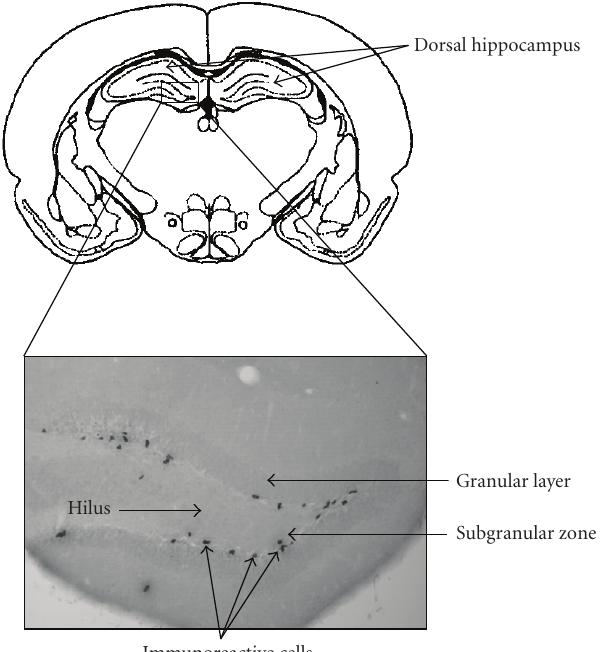
Figure 1: Photomicrograph of BrdU-positive cells in the subgran- ular zone of the dentate gyrus 2 hours after BrdU administration in an 8-week-old C57BL/6J mouse. Magnification: